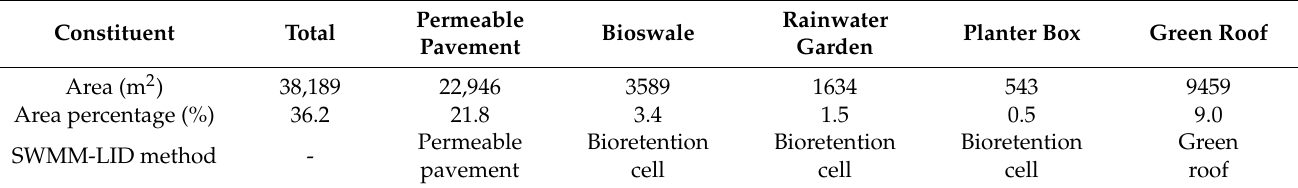
Table 6. Area of LID